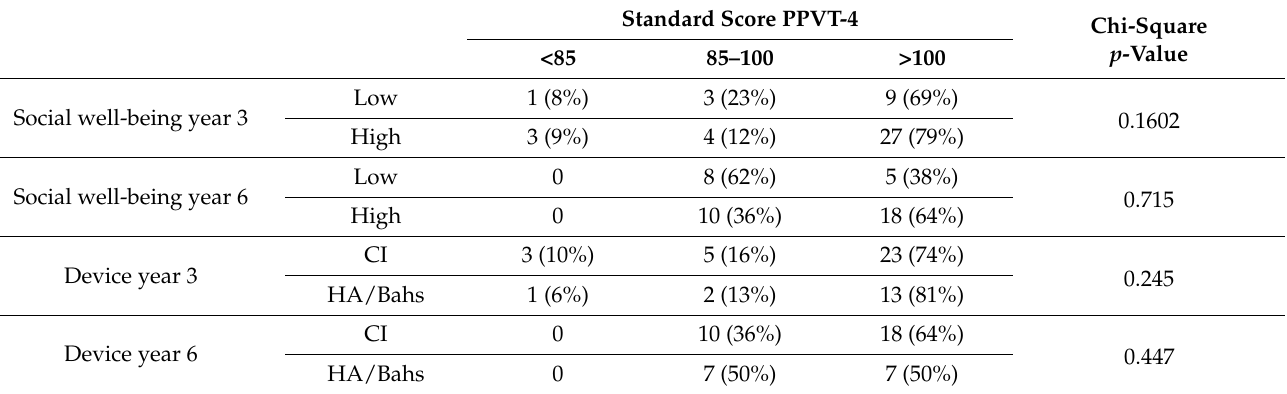
Table 2. Categories of standard scores vs. level of social well-being and device at year 3 and